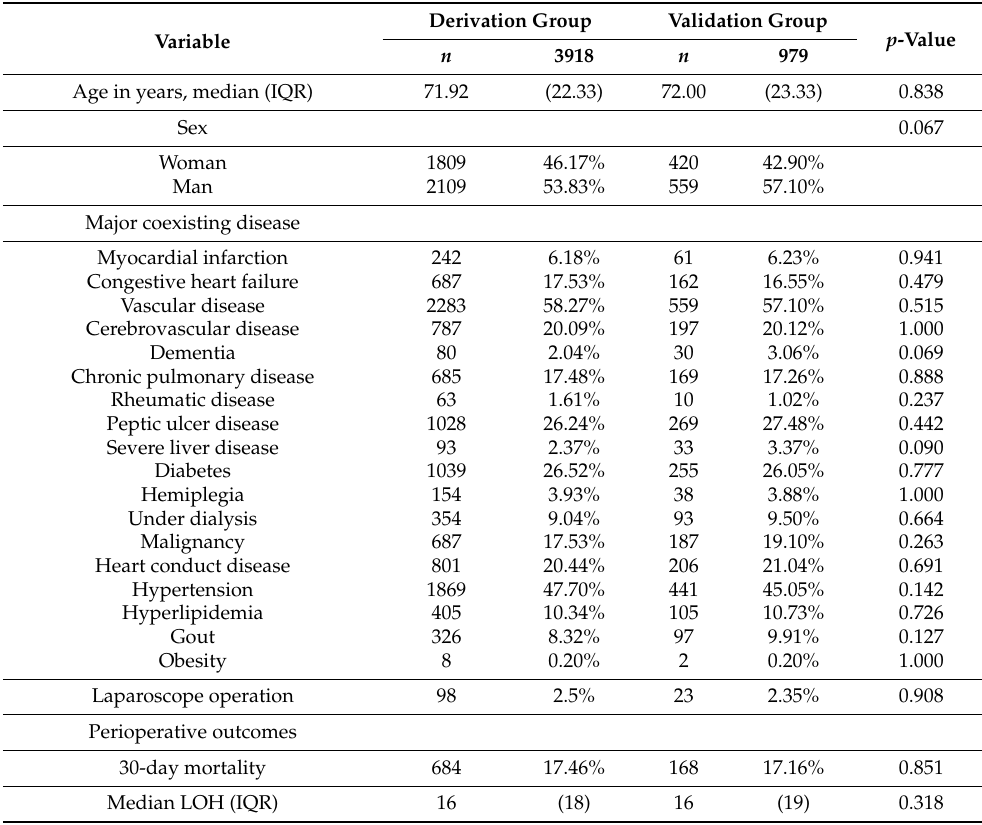
Table 1. Basic characteristics of patients in the derivation and validation